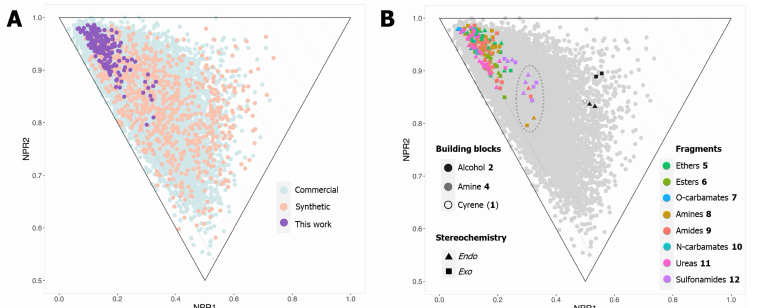
Figure 4. PMI plots of the Cyrene library. ( A ) Comparison of commercial “Fsp 3 ” and “3D” fragment libraries extracted from a recent review [39], 25 papers disclosing synthetic 3D fragment sets [40], and the current work. ( B ) Comparison of Cyrene, building blocks 2 and 4 , the various fragment classes, and associated stereochemistry in the current work. The collected data points from the commercial and synthetic libraries in Figure 4B are light-gray, and the dashed circle represents all compounds that tend to be located more toward the disc–sphere axis ( 8h,i / 9l / 12b,c,e ). Data points represent average PMI values per compound, obtained by averaging PMI values of individual conformations ( ∆ E max ≤ 5 kcal · mol − 1 , RMSD > 0.1). The dashed straight line represents the cut-off for three-dimensionality (i.e., Σ NPR ≥ 1.07). For a given substituent both diastereomers are included as separate entries for the Cyrene